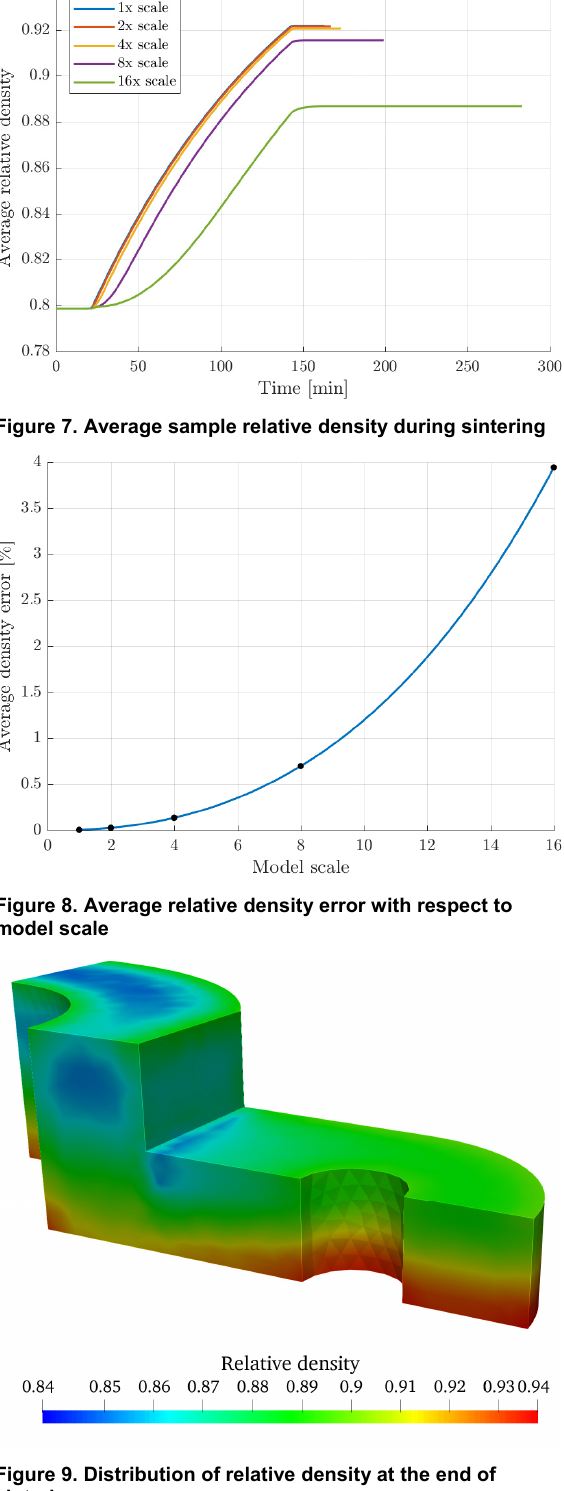
Figure 9. Distribution of relative density at the end of sintering